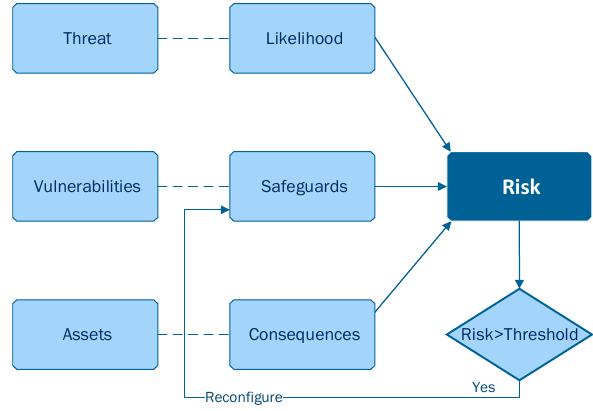
Figure 15. RheoStat: Real-Time Risk Management [76].